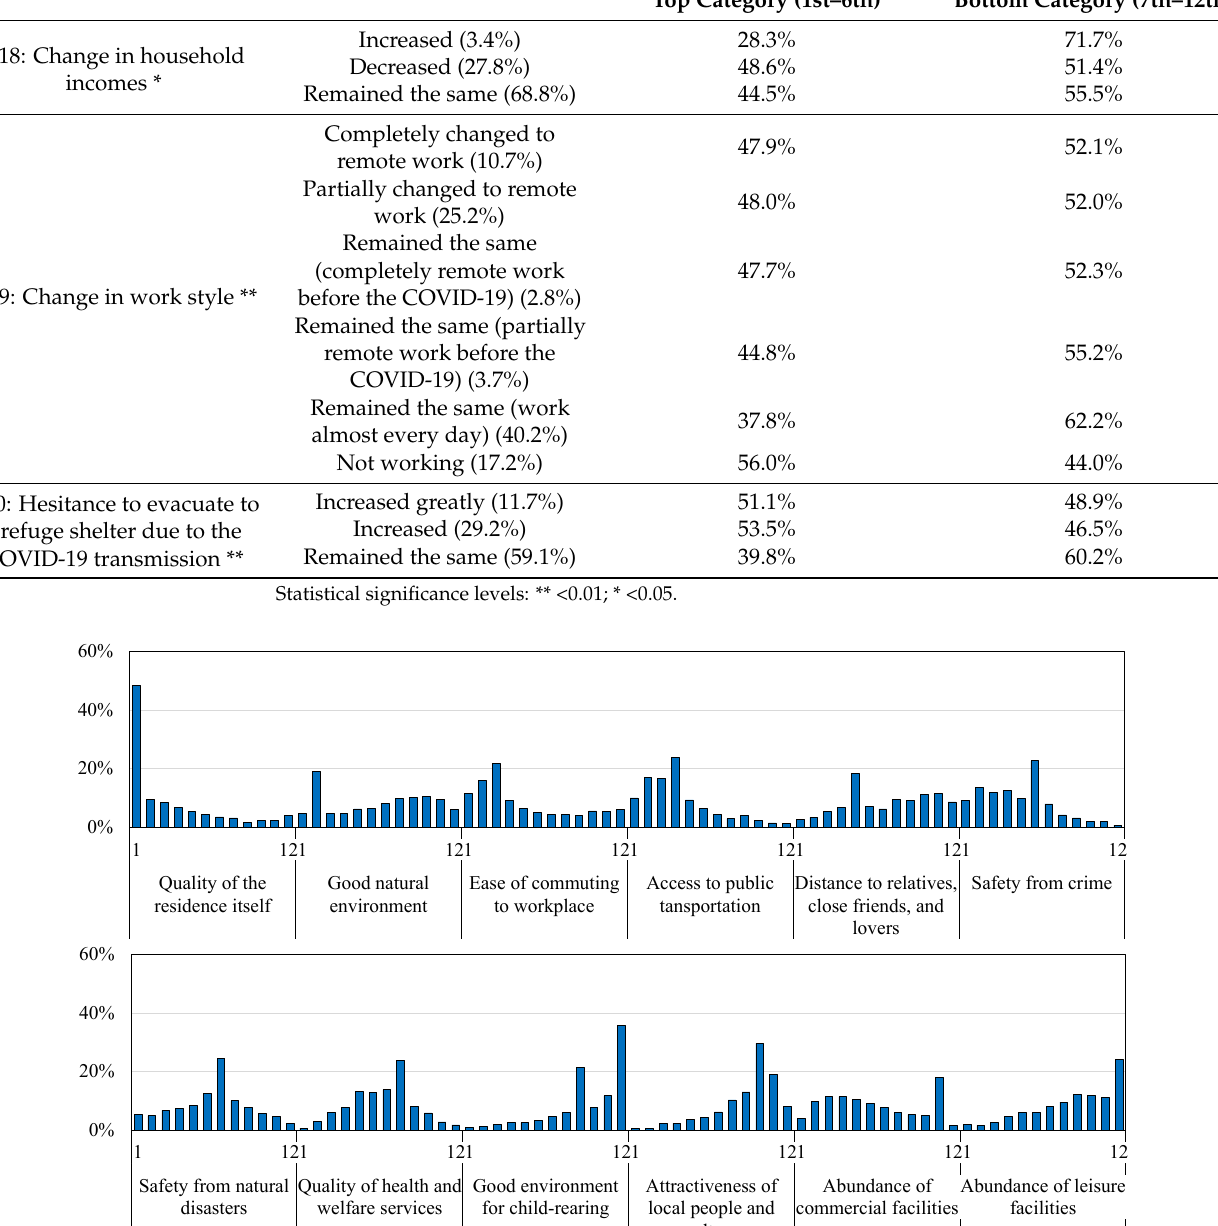
Figure 3. Percentage of respondents ranking each of the factors in the top (Rank 1st − 6th) or bottom (7th − 12th) categories ( n = 1554). The factor “safety from natural disasters” was most frequently ranked as seventh, while 45.1% selected it in the top category. Comparing the percentages in which each fac- tor was selected in the top category, the percentage of “safety from natural disasters” was lower than that of “quality of the residence itself,” “good natural environment,” “ease of commuting to workplace,” “access to public transportation,” “safety from crime,” and “abundance of commercial facilities” but higher than that of the “distance to relatives, close friends, and lovers,” “quality of health and welfare services,” “good environment for child-rearing,” “attractiveness of local people and culture,” and “abundance of leisure facilities.” 3.3. Personal Attributes Associated with the Relative Preference for Living in a Safer Place from Natural Disasters The percentages by which “safety from natural disasters” was selected in the top and bottom categories for each of the responses are shown in the right columns in Tables 1–4. When the questions (or responses for the case of questions that allowed multiple choices) had significant associations with the responses regarding whether “safety from natural disasters” was ranked in the top category or not (through the chi-square tests), the signif- icance level was shown with the asterisks: ** <0.01 and * <0.05.